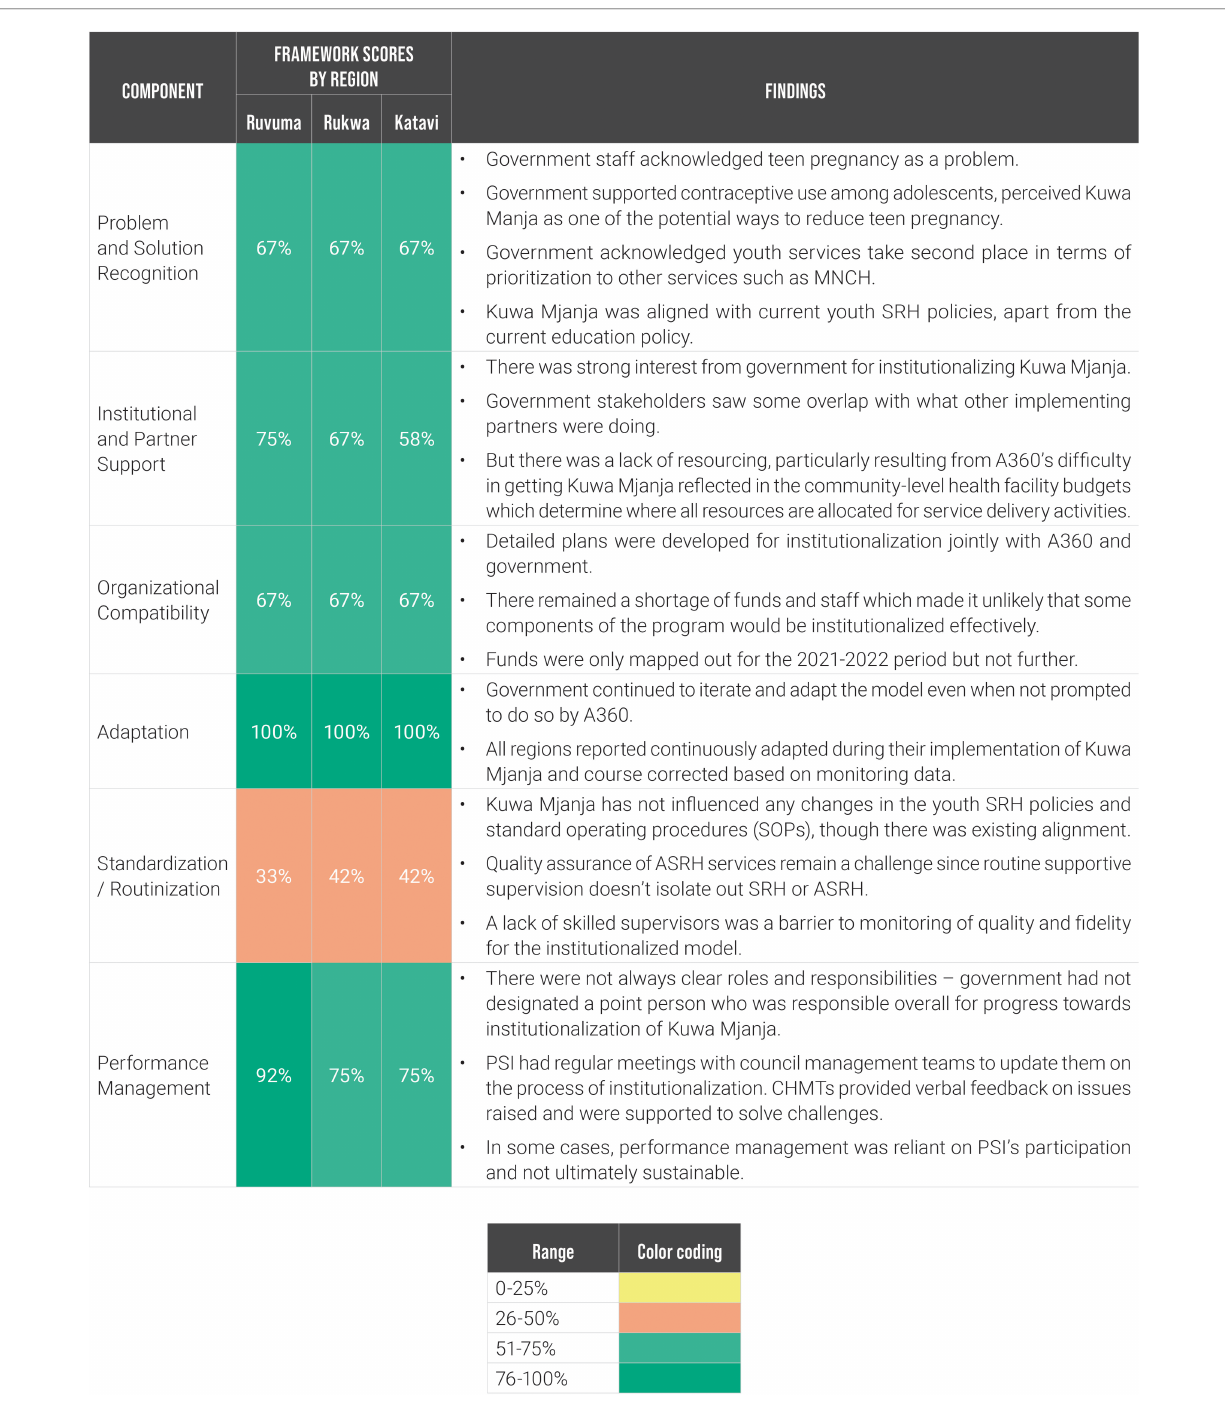
FIGURE 6 Milestone framework scores and contextual fi ndings for Kuwa Mjanja institutionalization by priority region, Q4